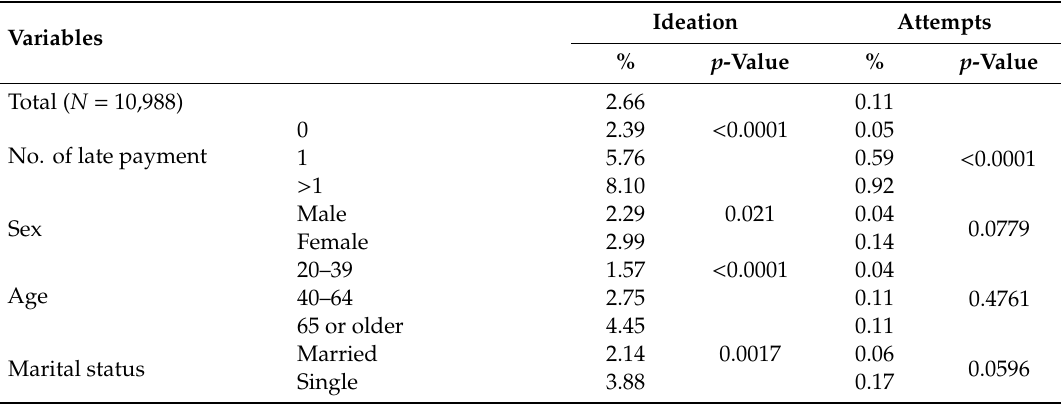
Table 2. Proportion of individuals with suicidal ideation and